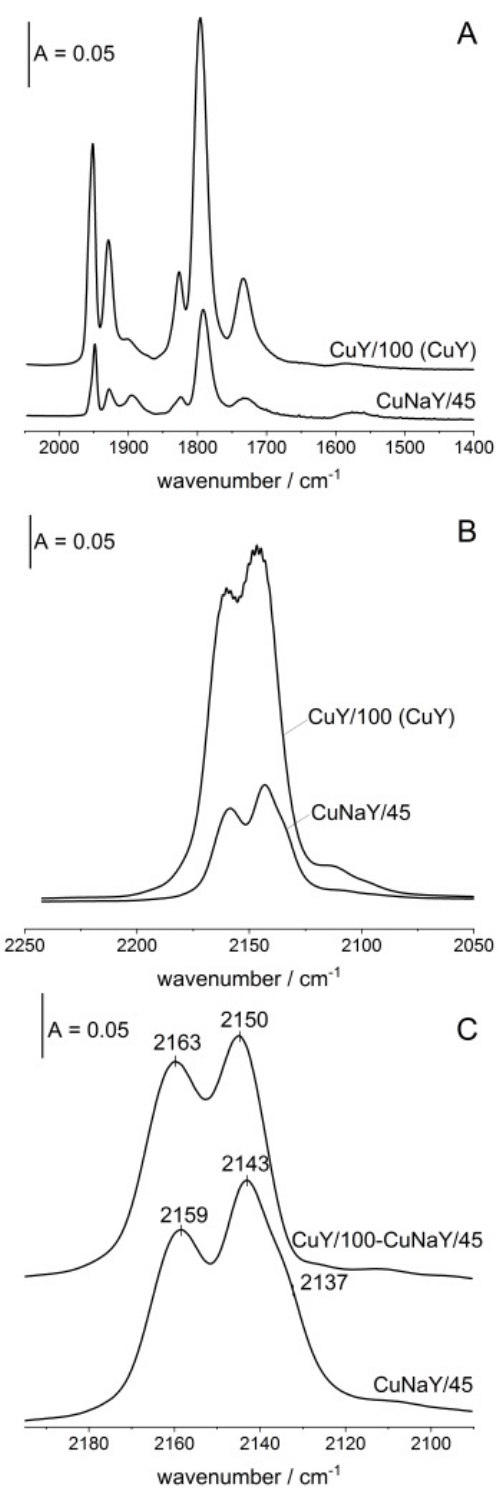
Figure 6. ( A , B ) The spectra of NO ( A ) and CO ( B ) sorbed at 170 K (NO) and at room temperature (CO) in zeolites of exchange degrees 100% and 45%. ( C ) Differences between the spectra of CO sorbed in zeolites of various Cu contents. Spectra are normalized to the same band intensity.